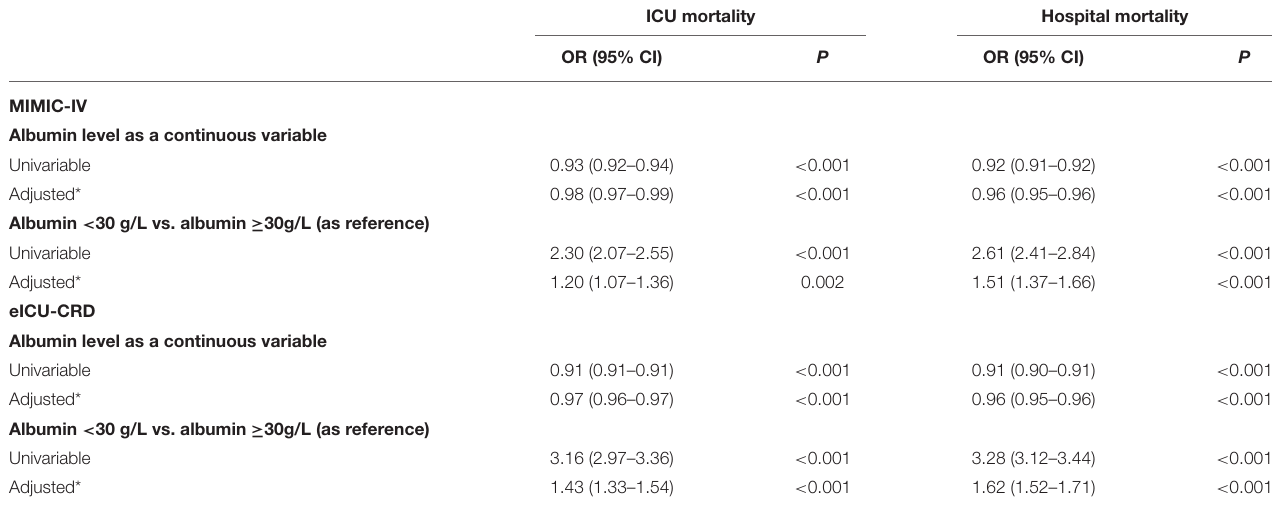
TABLE 2 | The association of serum albumin level with mortality risks.